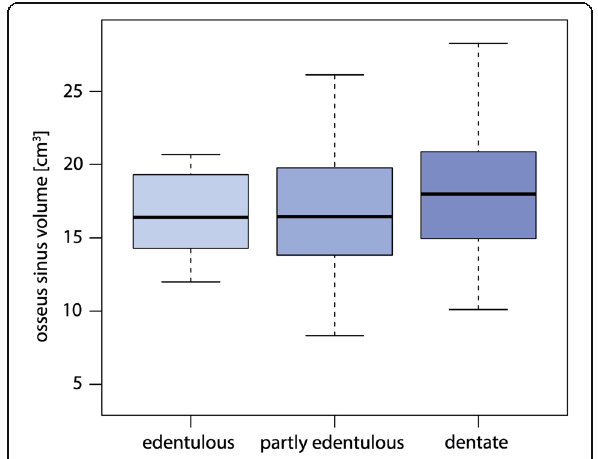
Fig. 4 The association between the osseus volume and the dentition. Edentulous, partly edentulous, and dentate patients showed no relevant difference in the size of the osseus sinus volume ( p = 0.52)